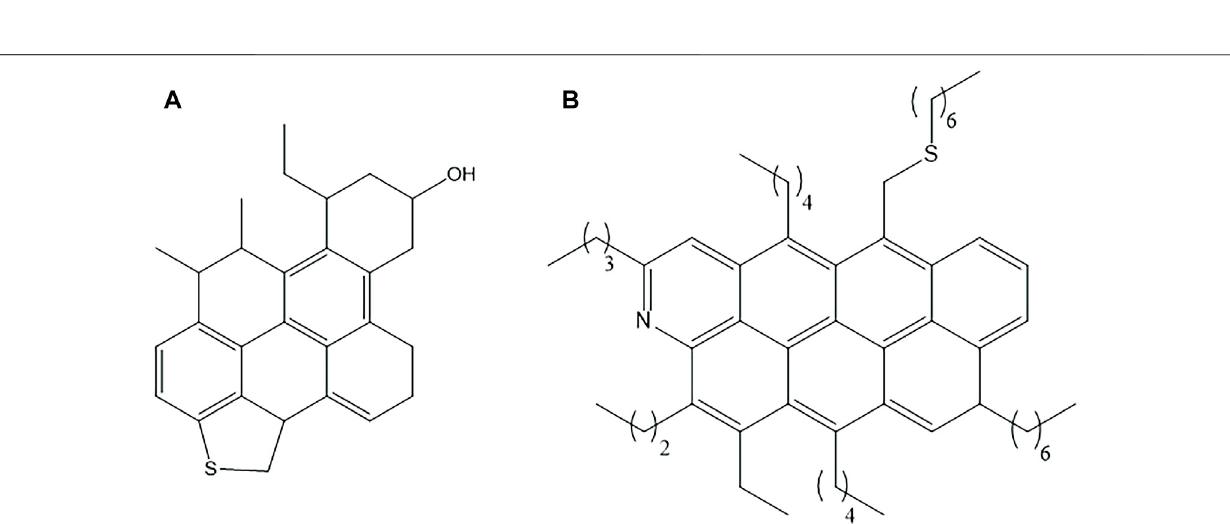
Frontiers in Environmental Science |